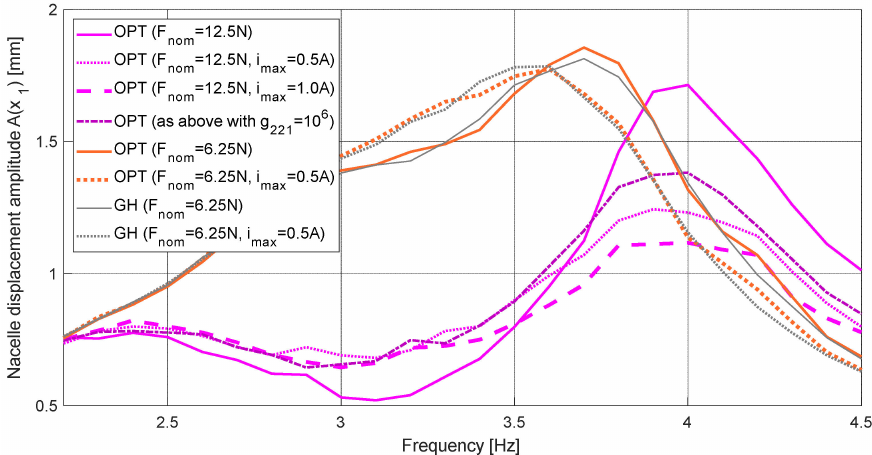
Figure 7. Nacelle horizontal displacement amplitude A ( x 1 ) frequency characteristics: OPT for different control parameter values vs. GH for F nom = 6.25